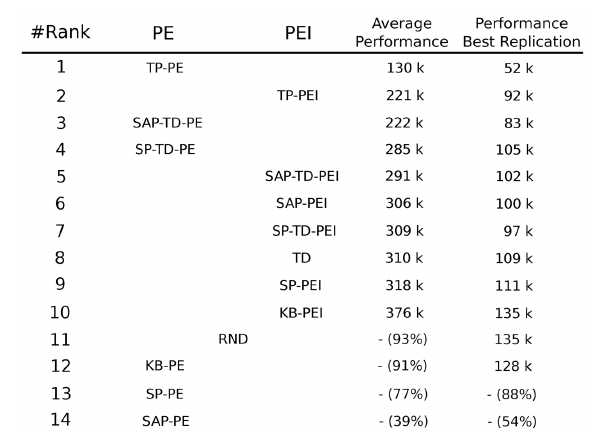
FIGURE 15 | Ranking of the different experimental conditions summarizing the result of both PE and PEI signals with respect to the ability to reach the target average performance of 95% in the four learnable tasks. For every condition the performance of the best replication is also shown. Performances are measured in thousands of trials. If a condition has not reached 95% at the end of the 400,000 trials of the experiment we report the average performance at the end of the